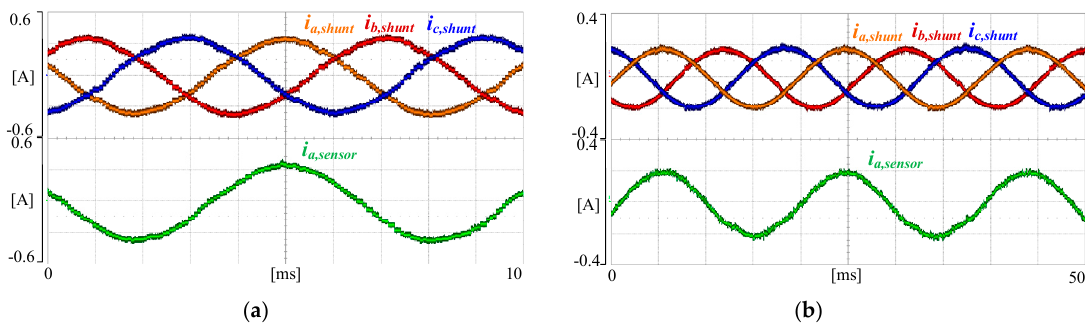
Figure 13. The phase current sampled through shunt resistor without the current reconstruction method at 400 rpm (Figure 4a) and 130 rpm (Figure 4b): ( a ) Current waveform from shunt resistor at 400 rpm; ( b ) current waveform from the shunt resistor at 130 rpm.